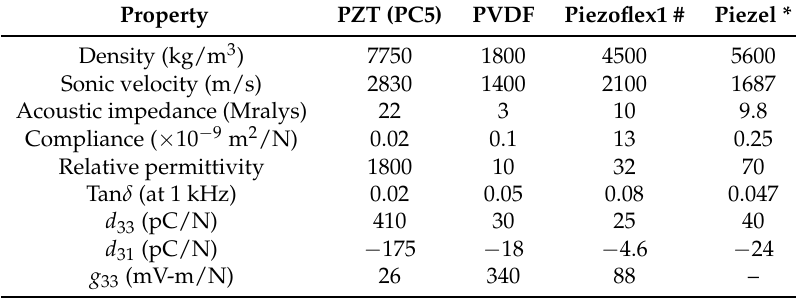
Physical properties of PZT (ceramic), PVDF (polymer), and Piezoflex and Piezel (composite materials).